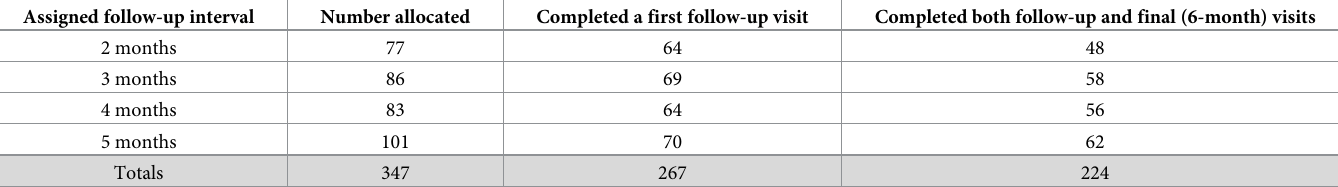
Table 1. Description of participation by follow-up visit and allocation